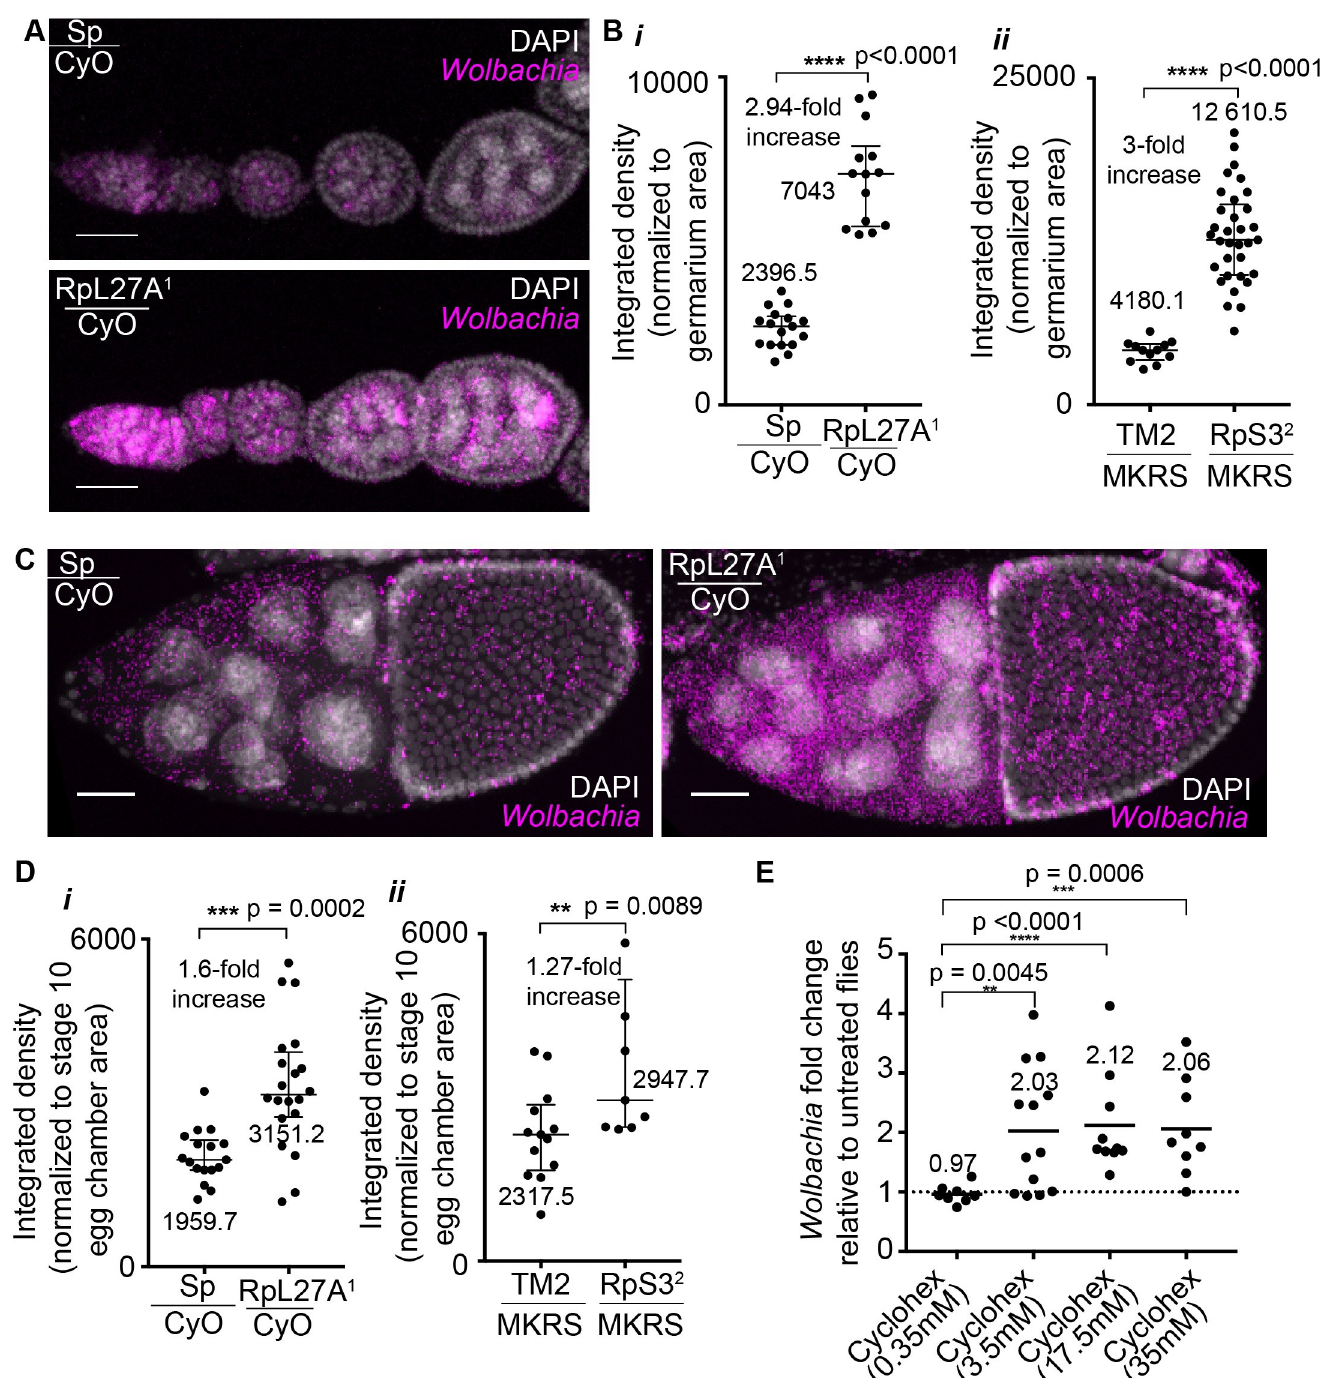
Fig 6. Perturbations in host ribosome or global translation lead to increased Wolbachia levels in the fly. (A, C) Wolbachia -infected ovarioles of control (Sp/CyO) and ribosome mutant (RpL27A 1 /CyO) siblings processed to visualize Wolbachia using a 23s rRNA FISH probe (magenta) and cell nuclei (DAPI) in early stages including the germaria ( A ) and later stages including stage 10 Drosophila egg chambers ( C ). Scale bars represent 33 μ m. ( B , D ) Quantification of integrated density of the Wolbachia FISH probe in germaria ( B ) and stage 10 egg chambers ( D ) collected from 15–25 Drosophila ovary pairs for each genotype. Bars represent median. Differences between control and mutant siblings is statistically significant (Non-parametric, Mann Whitney). ( E) Wolbachia -infected Drosophila flies fed on cycloheximide-containing food or control food for 7 days. Cycloheximide-fed flies displayed significantly increased Wolbachia levels in the whole fly as measured by DNA qPCR (Mann Whitney, p < 0.001). Results displayed as fold-change relative to control food fed flies. Each data point represents an individual fly. Bars represent mean fold change. See S10-14 for further results in the fly for ribosomal and proteasomal mutants.